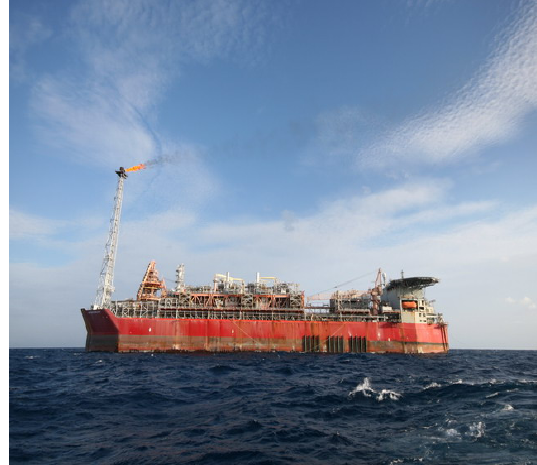
Fig. 1. FPSO Northern Endeavour